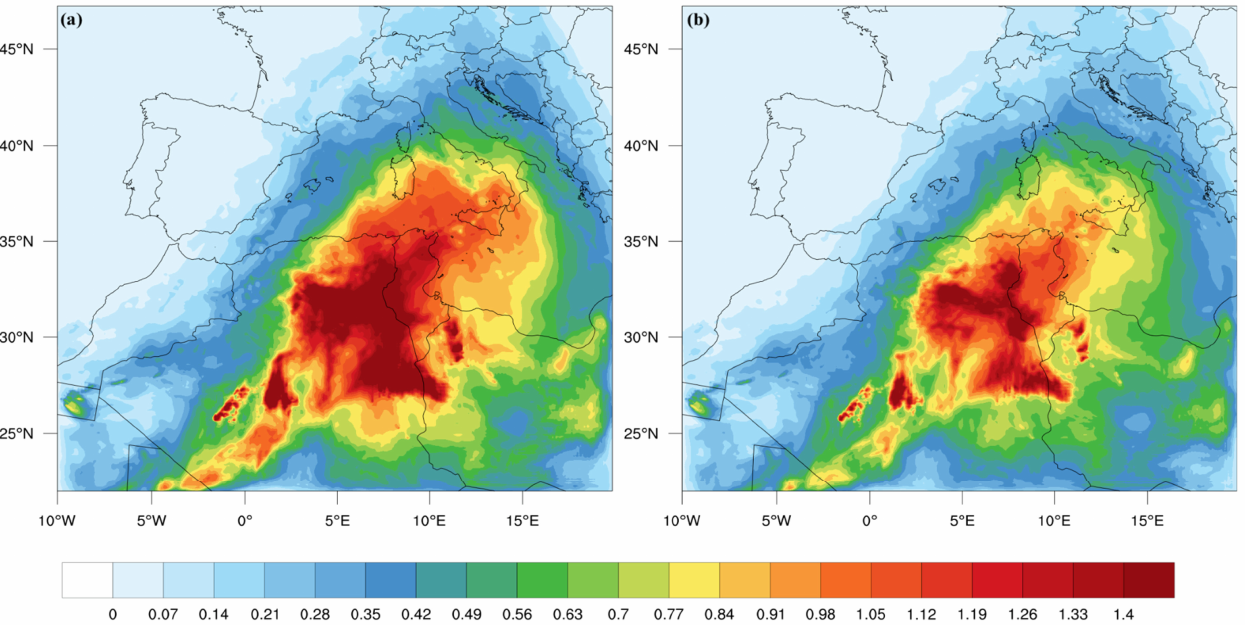
Figure 7. Period-averaged (17–24 June) aerosol optical depth at 0.55 µ m from the WRF-Chem model under ( a ) CTL and ( b ) FULL